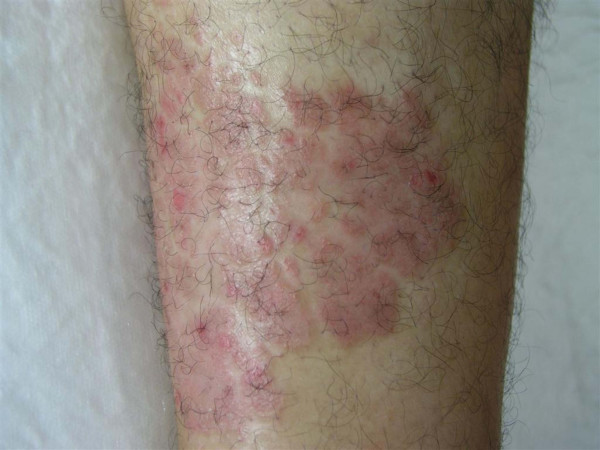
Scaly erythematous plaques of the lower extremity (psoriasis vulgaris).